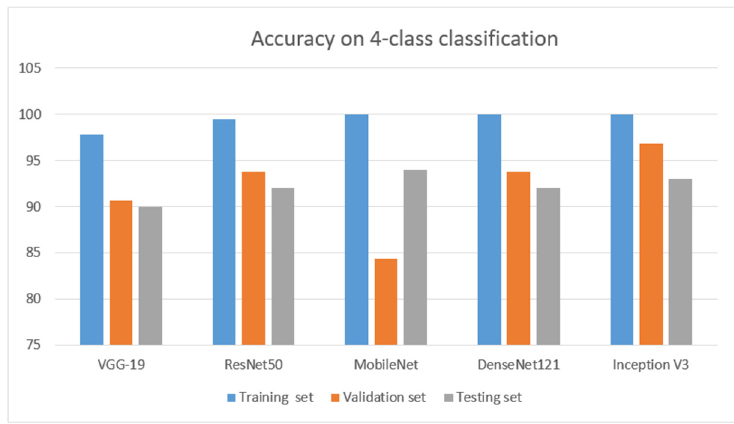
Figure 9. The plot shows accuracies compared for the 4-class classification.